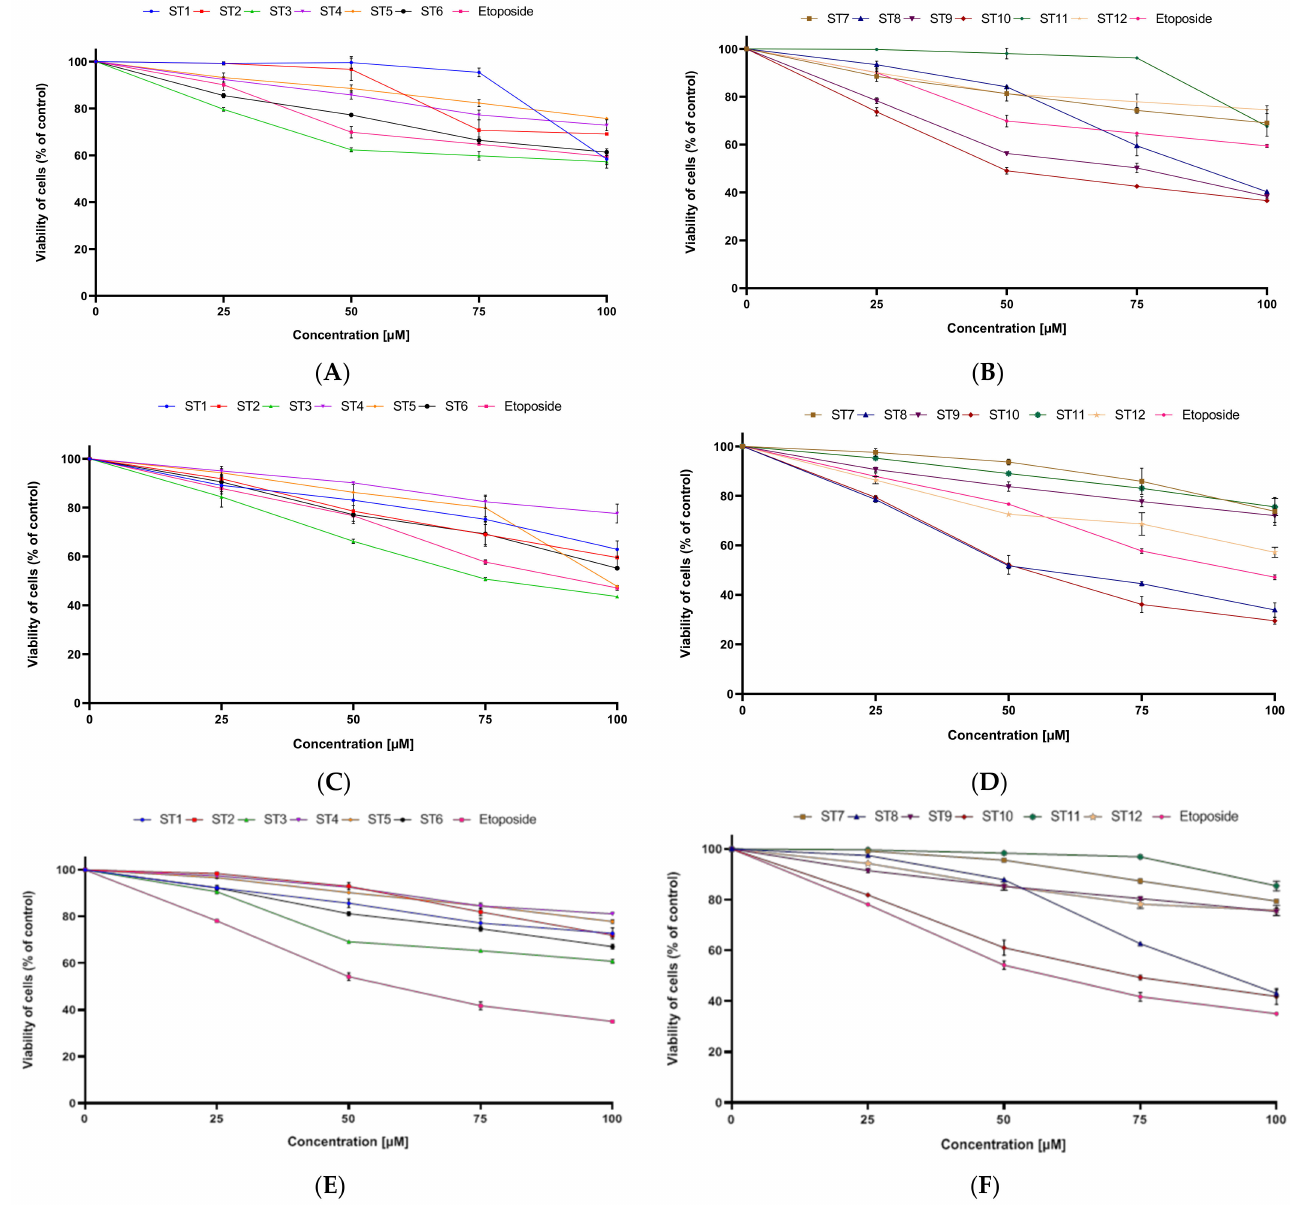
Figure 2. The viability of MCF-7 ( A , B ) and MDA-MB-231 ( C , D ) cells and fibroblasts ( E , F ) treated for 24 h with various concentrations of tested compounds ( ST1–ST12 ). Mean ± SD values from three independent experiments (n = 3) done in duplicate are